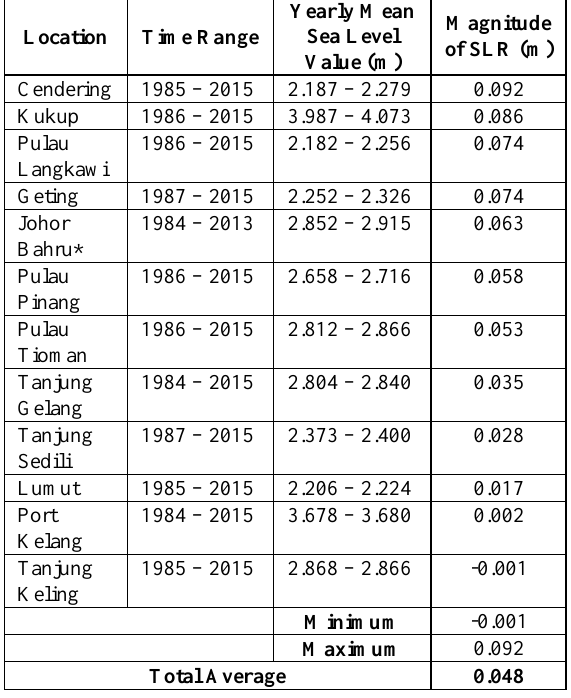
Table 3. Sea Level Rise Magnitude using Tidal Data (32 Years). *Johor Bahru Tide Gauge was stopped the operational in